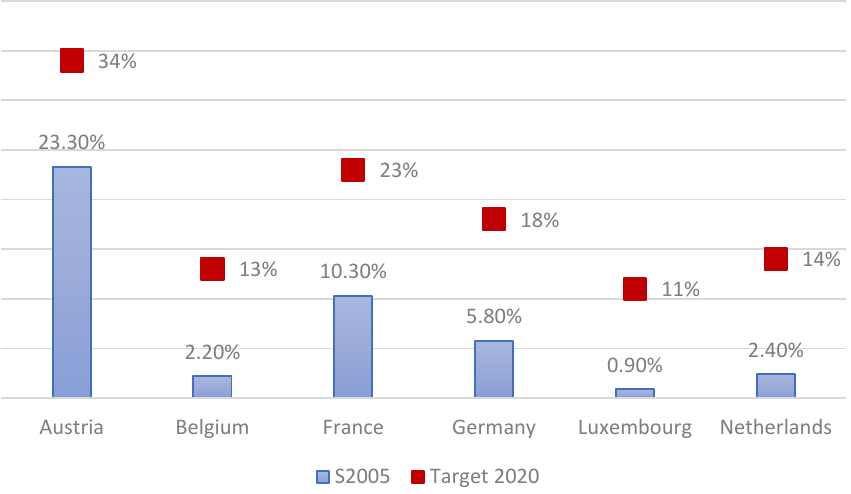
Figure 2. Starting point (S2005) and directive’s 2020 target for the sample member states. On the Y-axis, the percentage of energy achieved with respect to the final objective is shown.